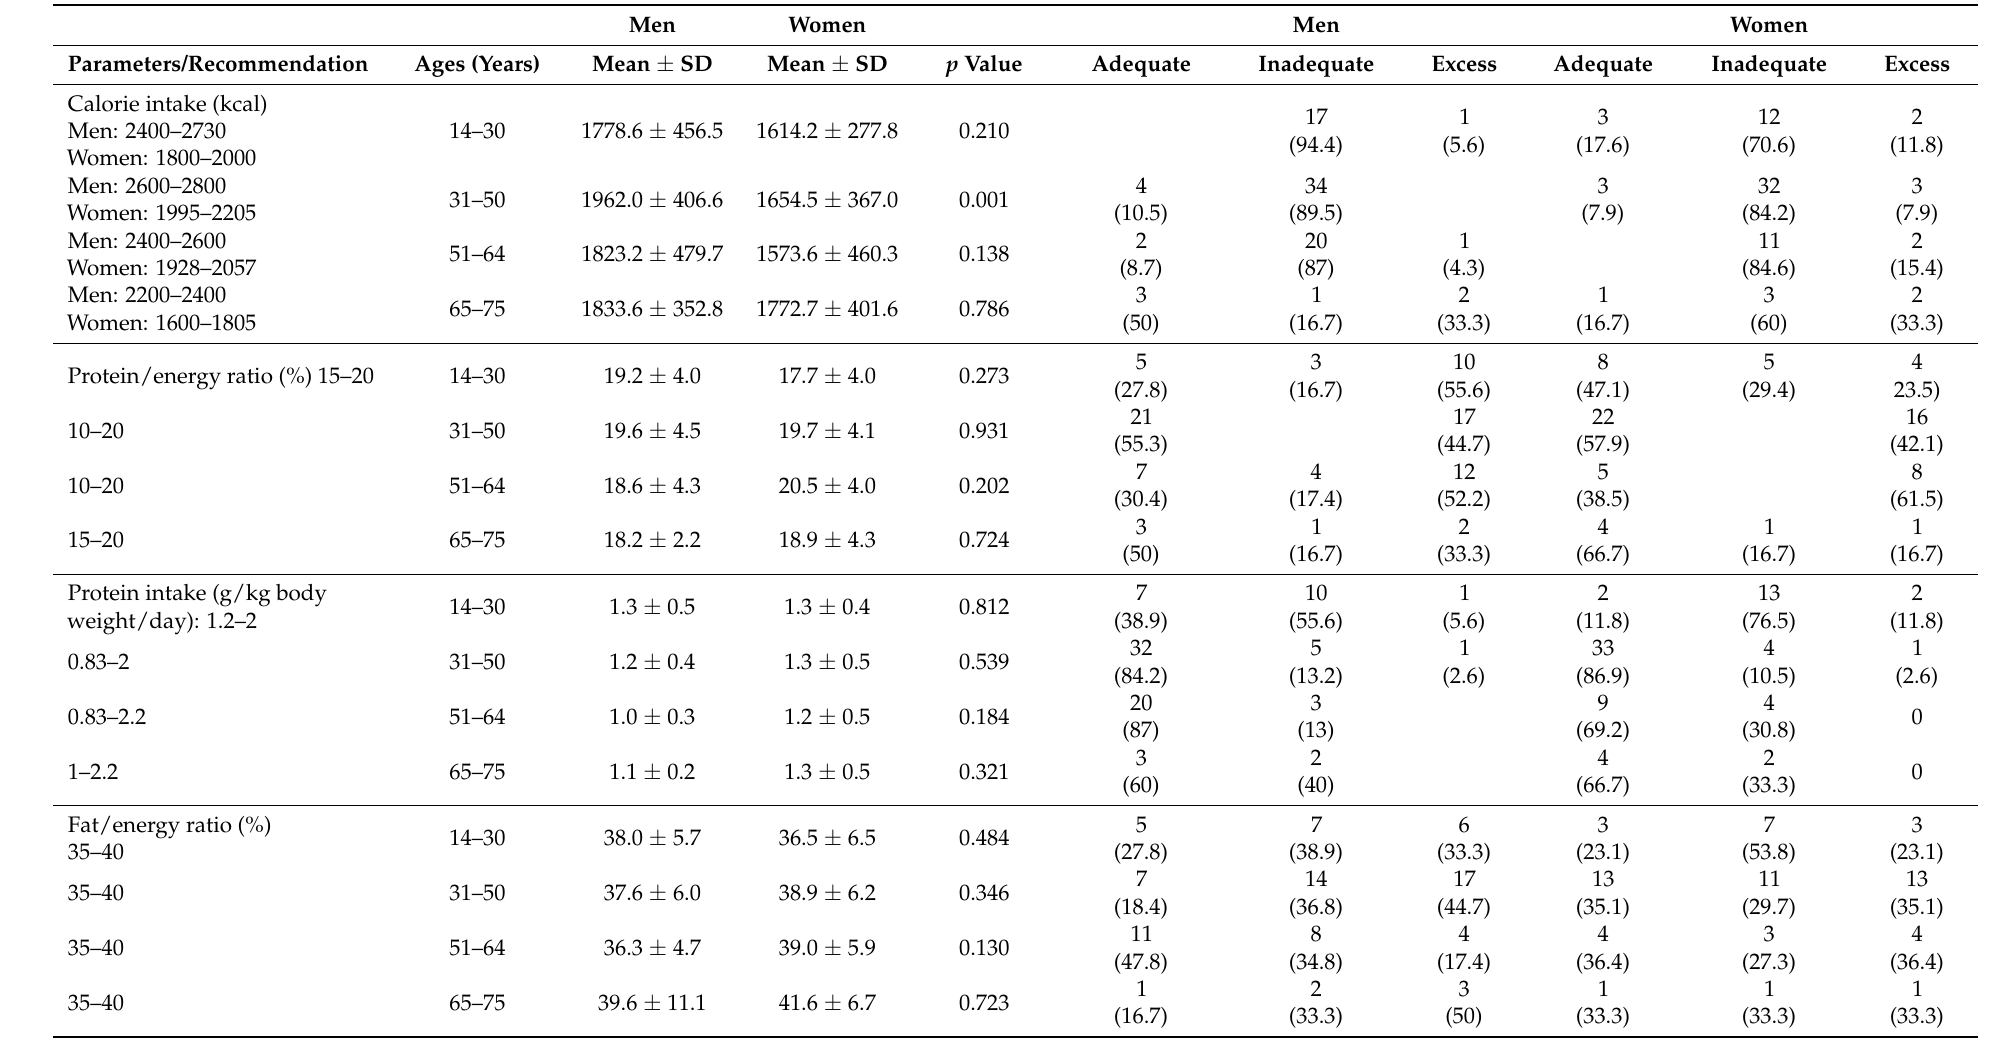
Table 5. Energy and macronutrient energy intake, intake adequacy analysis, and PAL in patients with FSHD categorized by